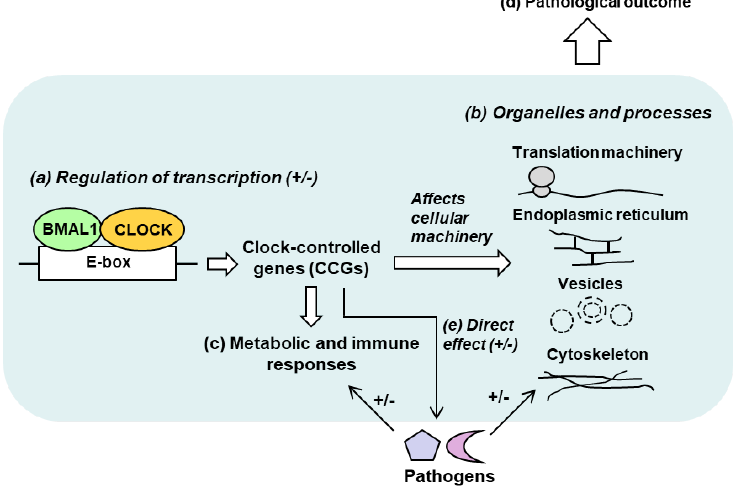
Figure 2. Schematic diagram of known and potential host-parasite interactions, relevant to the circadian clock. This is only a snapshot of the major systems in the proposed “Circadian–Metabolic–Microbial” Supersystem, described in greater detail in Section 7 and elsewhere. In its canonical role ( a ), the circadian BMAL1-CLOCK heterodimer transcriptionally activates a large number of clock-controlled genes (CCGs), although some other genes may be negatively regulated (denoted by +/ − ) [32–40]. The CCG products are structurally and / or functionally involved in modifying the cellular infrastructure and processes, such as specific organelles and ribosomes ( b ). They also a ff ect metabolic pathways, aging and immunity ( c ). Together, these e ff ects regulate the host’s response to infection positively or negatively (more or less susceptible to infection) [43]. The interaction can be reciprocal (not shown), i.e., the pathogen may also alter the clock, or suppress immunity [44]. The totality of these interactions a ff ects the end result, which is the pathology and the disease, caused by the infection ( d ). Finally, circadian genes themselves (e.g., BMAL1, CLOCK and others) or the CCGs can more directly participate in pathogen replication ( e ). These have been elaborated in appropriate